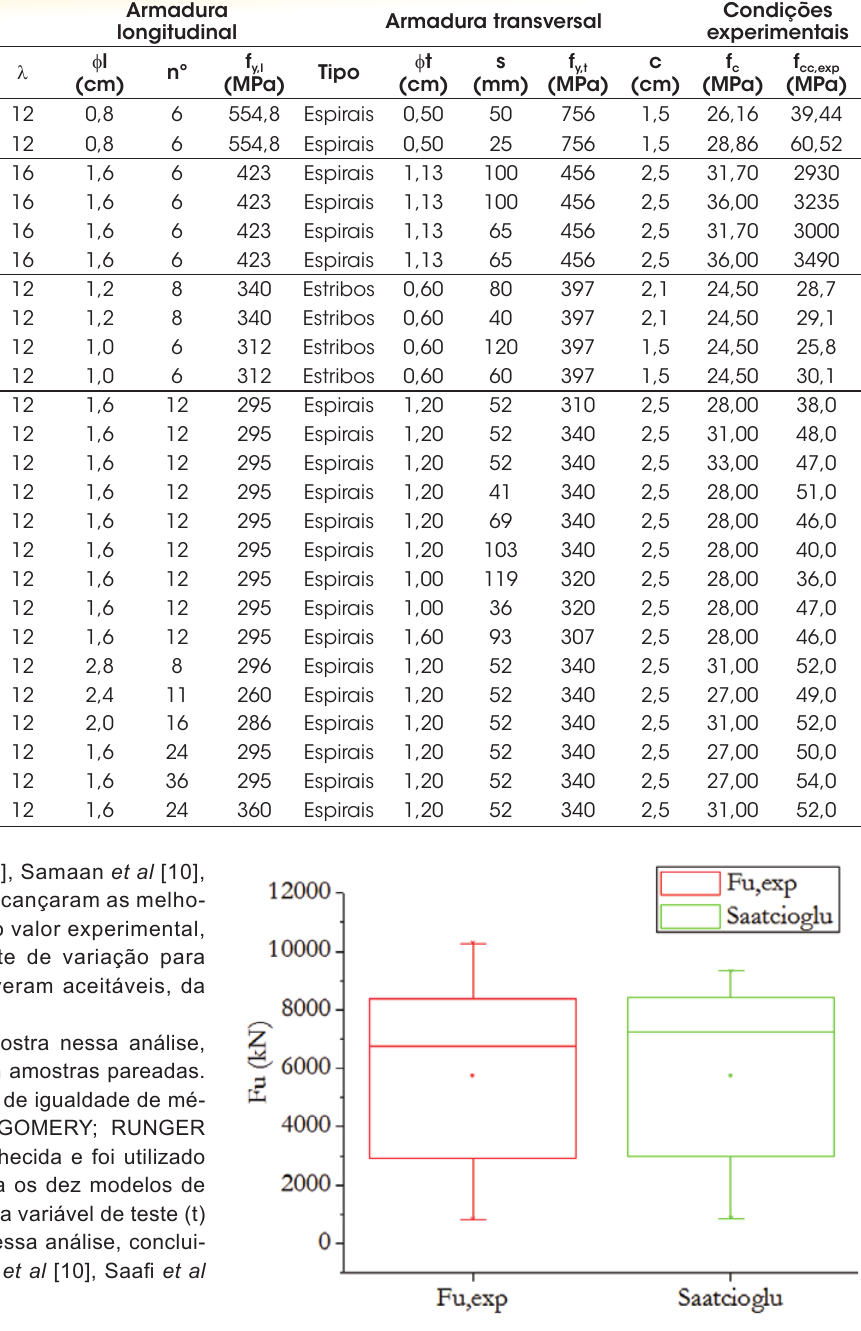
Figura 8 Variabilidade do modelo de Saatcioglu e Razvi [3] em relação aos valores experimentais